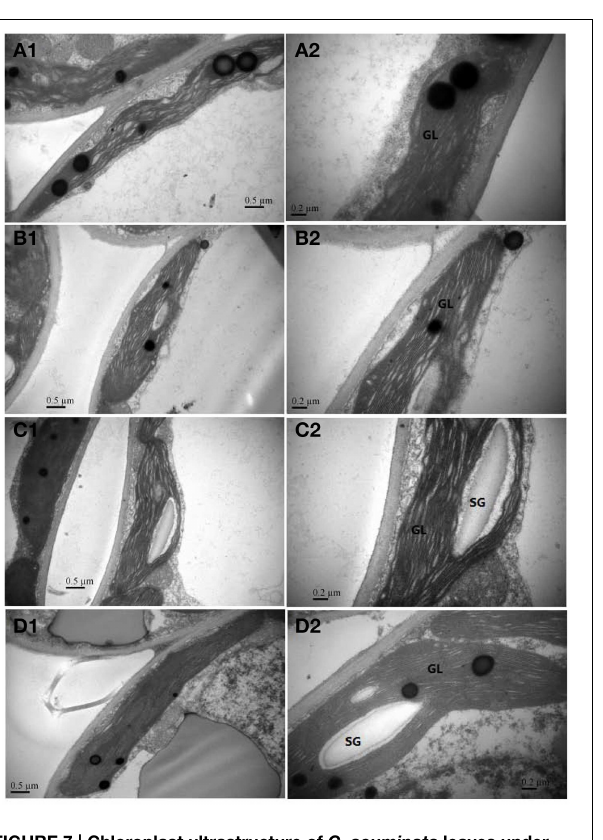
FIGURE 7 | Chloroplast ultrastructure of C. acuminata leaves under (A1,A2) 100% irradiance, (B1,B2) 25% irradiance,